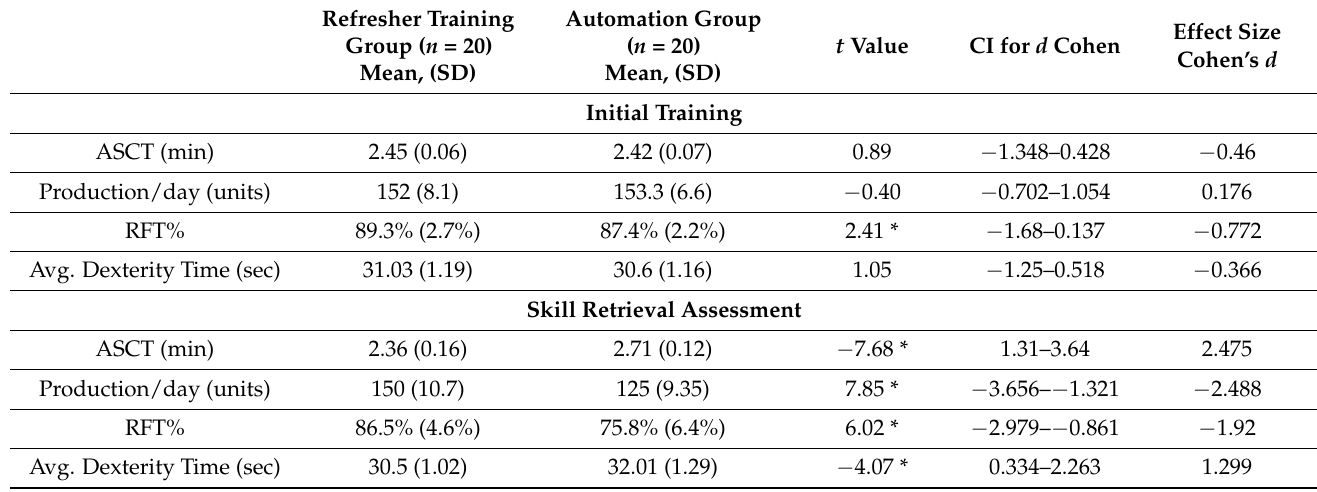
Table 3. Skill retrieval assessment among the RTG and AG using independent samples t